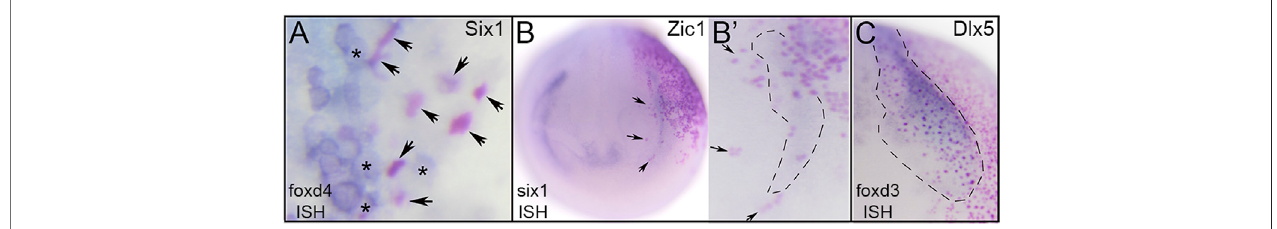
FIGURE 6 | TF effects are cell-autonomous at gastrula stages but likely include signaling to neighbors at neurula stages. (A) Dorsal midline of gastrula showing Six1-expressing cells that have lineage-labeled nuclei (arrows, red dots). Each of the lineage-labeled cells showed reduced foxd4 expression (clear cytoplasm). In contrast, uninjected neighbors (asterisks, clear nuclei) showed high levels of foxd4 expression (blue cytoplasm). (B) Ectopic expression of Zic1 (NC TF) in a placode precursorblastomere(reddots)showingZic1-expressingcellsonrightsideofneurulastageembryo(rednuclei)overlappingwiththereduced six1 PPRexpression domain(blue).Anteriorviewwithdorsaltothetop.B ′ showsahighermagni fi cationofthe six1 PPRdomainontheinjectedside.Fororientation,arrowspointtothesame cells asinB. Each ofthelineage-labeled cellsshowedreduced six1 PPRexpression, butwithinthe regionsurrounded bythedashed line,uninjected neighborsalso had reduced expression. (C) Ectopic expression of Dlx5 (Epi TF) in a neural crest precursor blastomere (red dots) showing Dlx5-expressing cells (red nuclei) within the foxd3 neural crest expression domain outlined by dashes ofa neurula stage embryo. Within that domain, lineage-labeled cells showed reduced foxd3 neural crest expression, but it also was reduced in adjacent uninjected neighbors. Anterior view with medial to the left and dorsal to